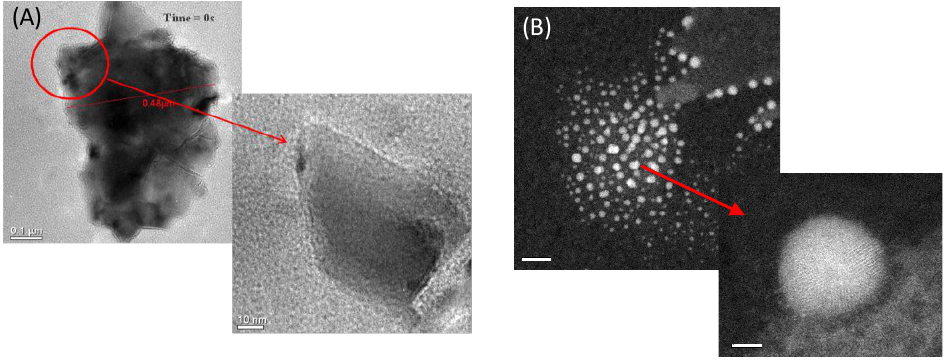
Figure 4. ( A ) Dark field and bright field STEM images corresponding to LiNbO 3 without heat-treatment (scale bar 0.1 μm) and ( B ) with heat treatment reduction at 650 °C (scale bar 20 nm). ( A ) Mono-dispersed Lithium Niobate and ( B ) nanoparticle of Lithium Niobate.